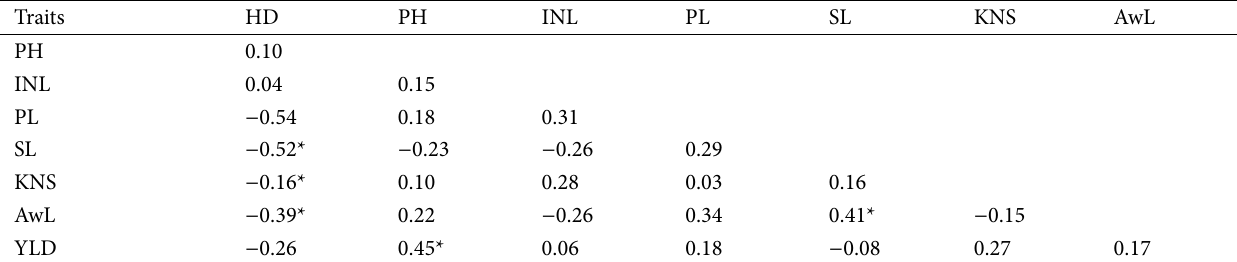
Table 4 Pearson coefficients of correlation between studied traits.